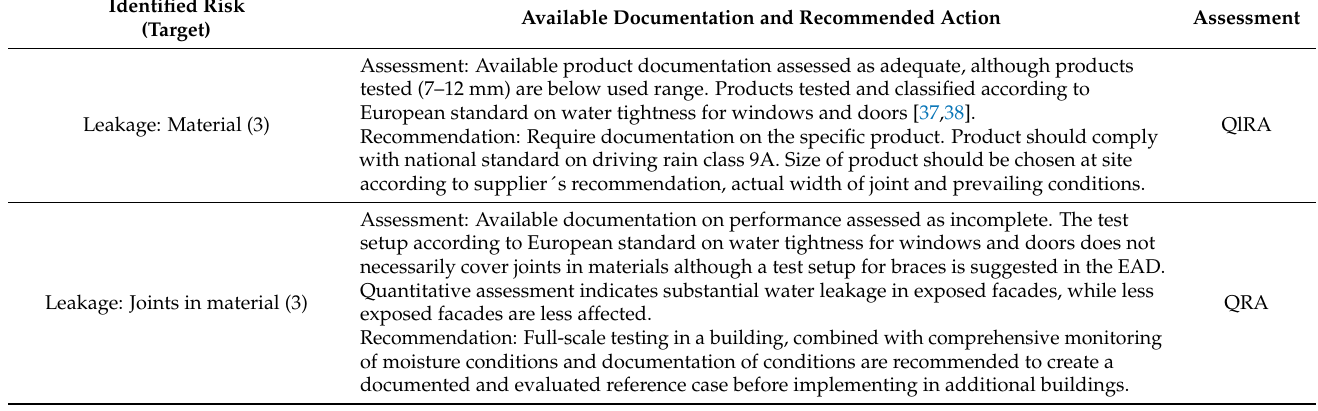
Table 12. Identified risk clusters with target according to Table 2 in brackets and corresponding perceived importance to fulfilment of performance requirements. Basis of assessment is given in the table as qualitative risk assessment (QlRA) or quantitative risk assessment